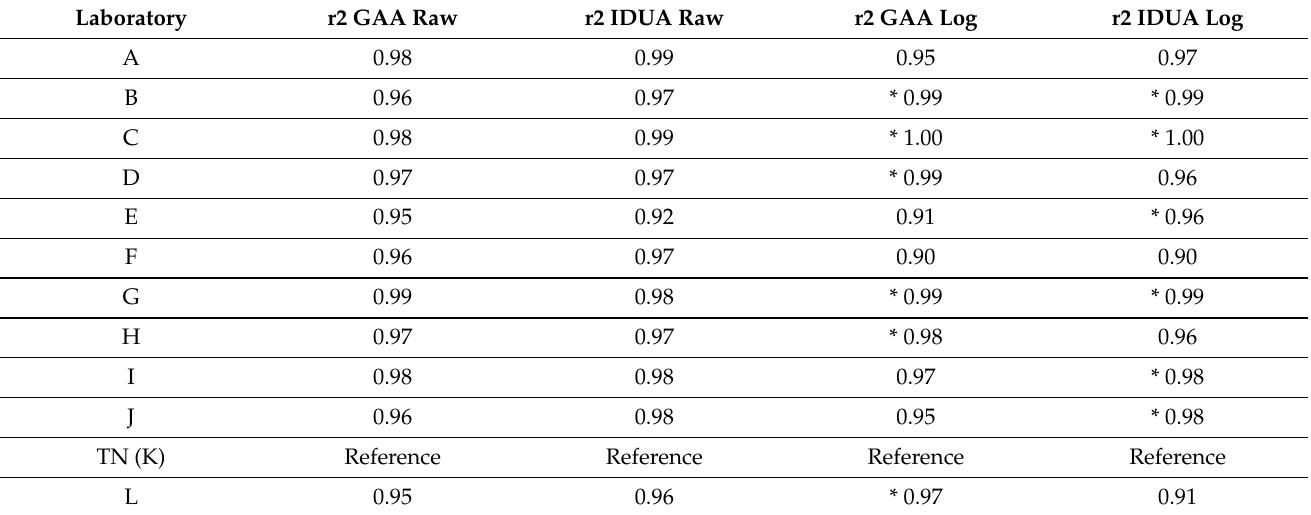
Table A1. r2 for raw and log enzyme activity for each lab.